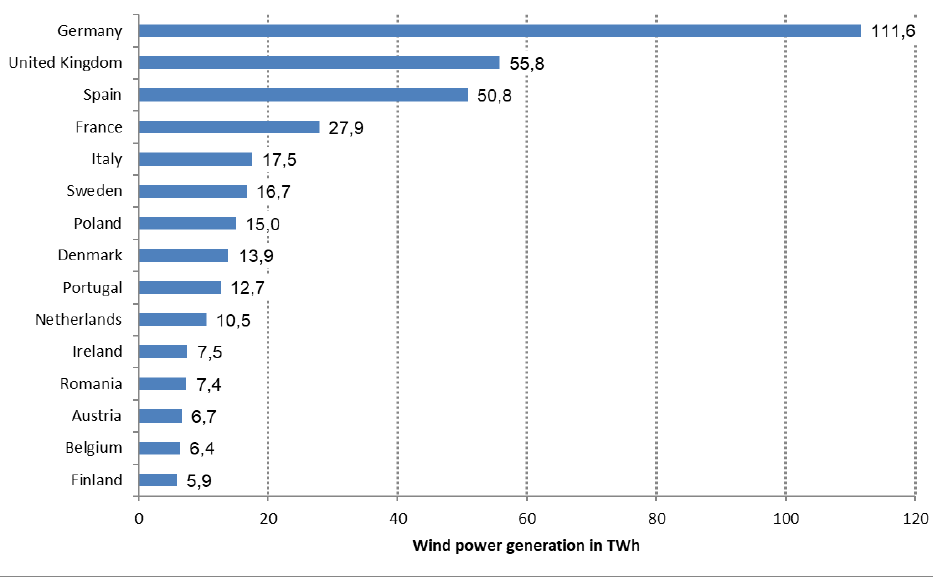
Figure 3. Most important countries in Europe, according to the amount of electricity generated from wind energy in 2018 (in terawatt hours) [5].